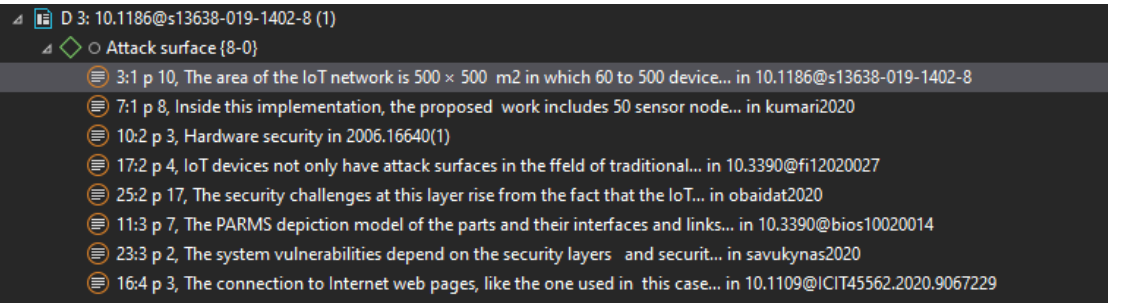
Figure 7. Components of attack surface in IoT systems according to quality analysis using Atlas TI.